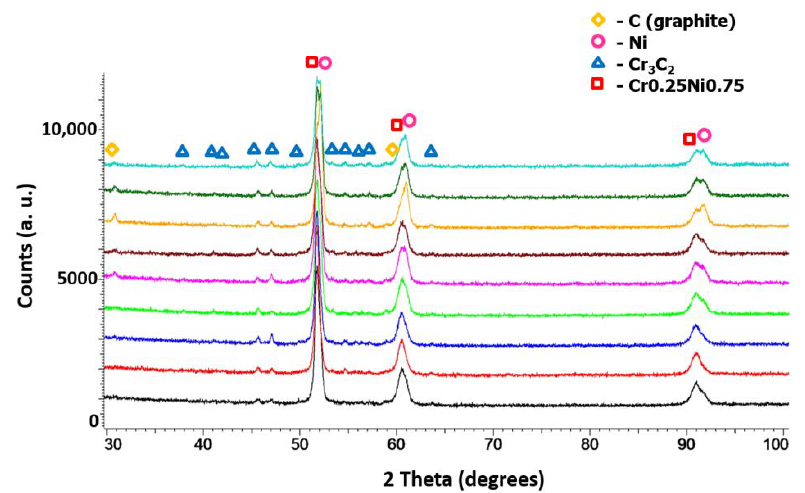
Figure 12. XRD patterns of Cr 3 C 2 -25(Ni20Cr)/Ni-25Graphite coatings deposited with the parameter sets from 1 to 9.